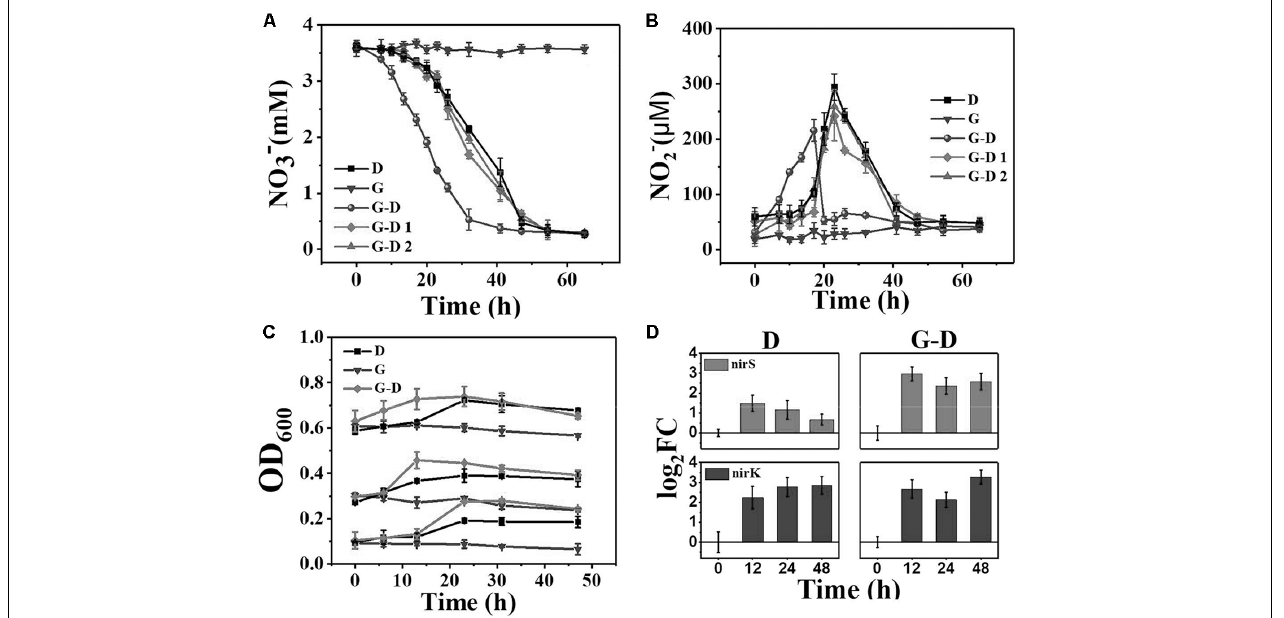
FIGURE 1 | The variations of nitrate (A) and nitrite (B) concentrations in 65 h since the medium change ( t = 0) at the C/N ratio of 6. D is denitrifying microbial community, G is the pure G. sulfurreducens PCA, G-D is G. sulfurreducens PCA added denitrifying microbial community. G-D 1 and G-D 2 are UV and ultrasonic inactivated G. sulfurreducens PCA added denitrifying microbial communities. (C) OD 600 variations of groups D, G and G-D with initial values of 0.1, 0.3, and 0.6. Fold changes (D) in nirS , nirK expressions in Groups D and G-D represented as the log2 transformed value. Relative transcript ratios with 16S rRNA as reference were used to determine fold changes as compared to that of the 0 h sample. Error bars represent standard deviation from three parallel